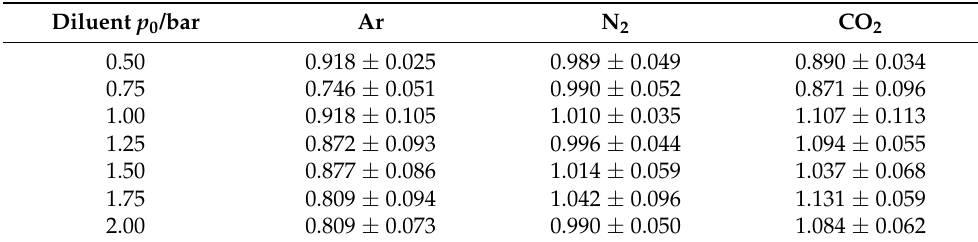
Table 6. Thethermalcoefficients, α , ofexperimentalPVsforstoichiometricC 3 H 8 –air+10% diluent mixtures. Diluent p 0 /bar